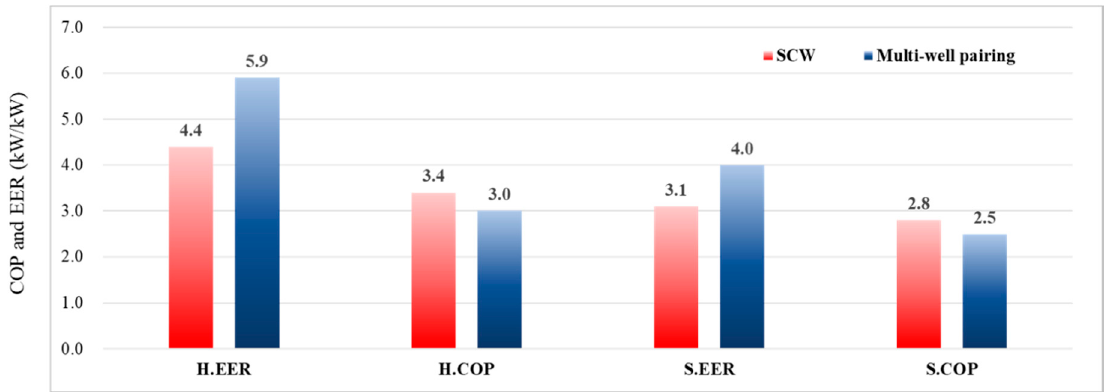
Figure 7. The cooling and heating performance of the standing column well (SCW) system and multi-well pairing system.